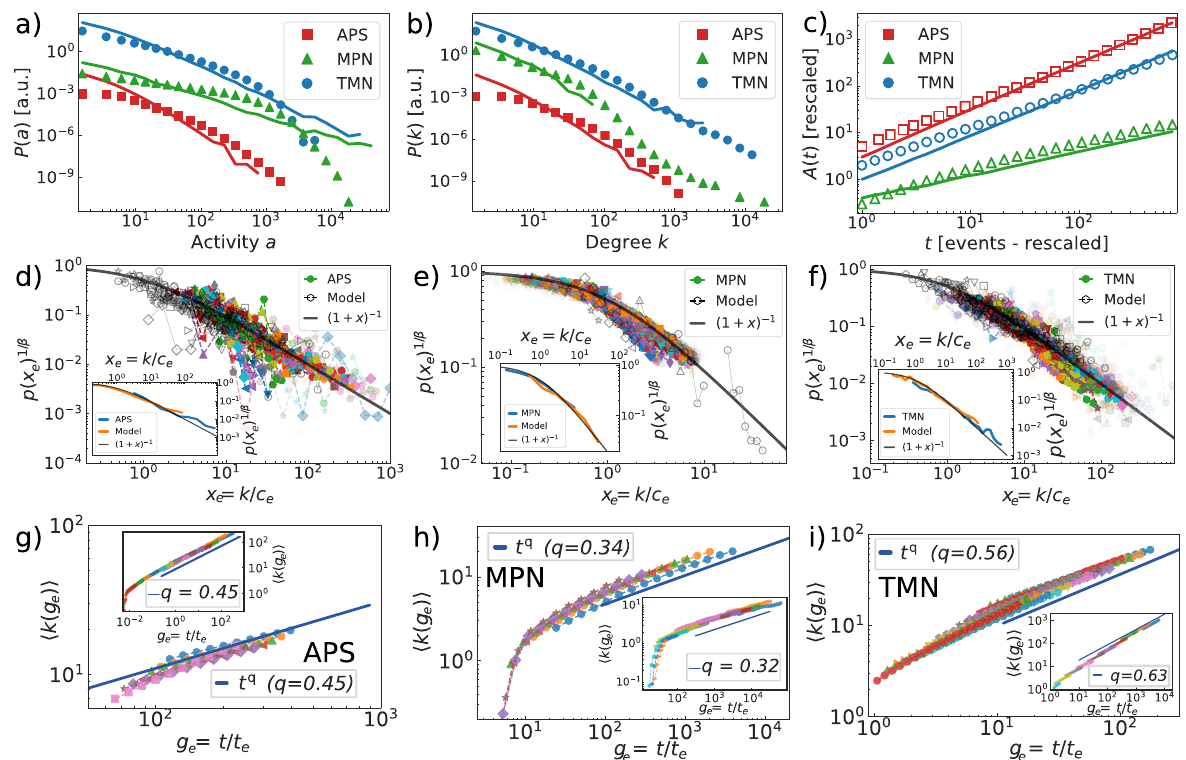
Fig. 1 Stylised facts in social networks ’ evolution: empirical data and model predictions. a The P ( a ) activity distribution, ( b ) the P ( k ) degree distribution, and, ( c ) the temporal growth of the total number of edges A ( t ) ∝ t γ as found in the American physical society (APS, red squares), mobile phone network (MPN, green triangles) and Twitter mention network (TMN, blue circles) datasets. In each panel, we also show the same curves as found in the best fi tting model of each dataset (solid lines with the same colour as the corresponding dataset). The rescaled strengthening probability p e ð k Þ ¼ ð 1 þ k = c e Þ (cid:2) β , being c e the memory constant for nodes of class e , as measured for different classes of nodes (symbols, colour depth proportional to the number of agents in a node class e ) is reported in panel ( d ) for the APS dataset, in ( e ) for the MPN case, and, in ( f ) for the TMN system. In the main panels, we compare the empirical ð x Þ 1 = β ¼ curves (coloured symbols) with the p e ( k ) found in the corresponding best- fi tting urn model (black symbols) and the theoretical guideline p (cid:4) (cid:5) e e ð 1 þ x Þ (cid:2) 1 (black solid lines), being x = k / c ð x Þ for the empirical (blue lines) and e the rescaled degree x e e . In the insets, we show the average rescaled p e e e e synthetic data (orange lines) as well as the theoretical behaviour p ( x ) = (1 + x ) − 1 (black line). We fi xed c e by fi tting the average p e ( k ) as measured for all the nodes belonging to the class e . g – i The average degree h k ð t e ; t Þi / ð t = t e Þ q as a function of the rescaled global time g e = t / t e for different classes of nodes entering the system at different times t e (coloured symbols) for the APS ( g ), MPN ( h ), and TMN system ( i ), respectively. In the insets, we show the (cid:4) (cid:5) / t q for all the cases (solid blue lines). Note that here the exponent q does not corresponding results for the urns model. We also show the best fi t k ð t Þ depend on class e